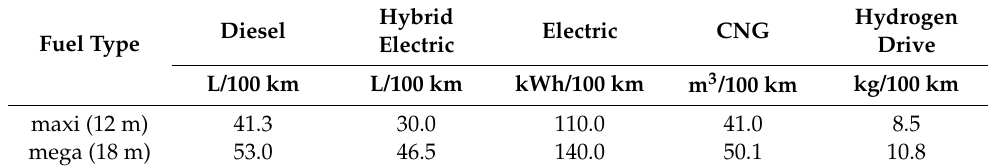
Table 6. Average fuel and energy consumption by buses.